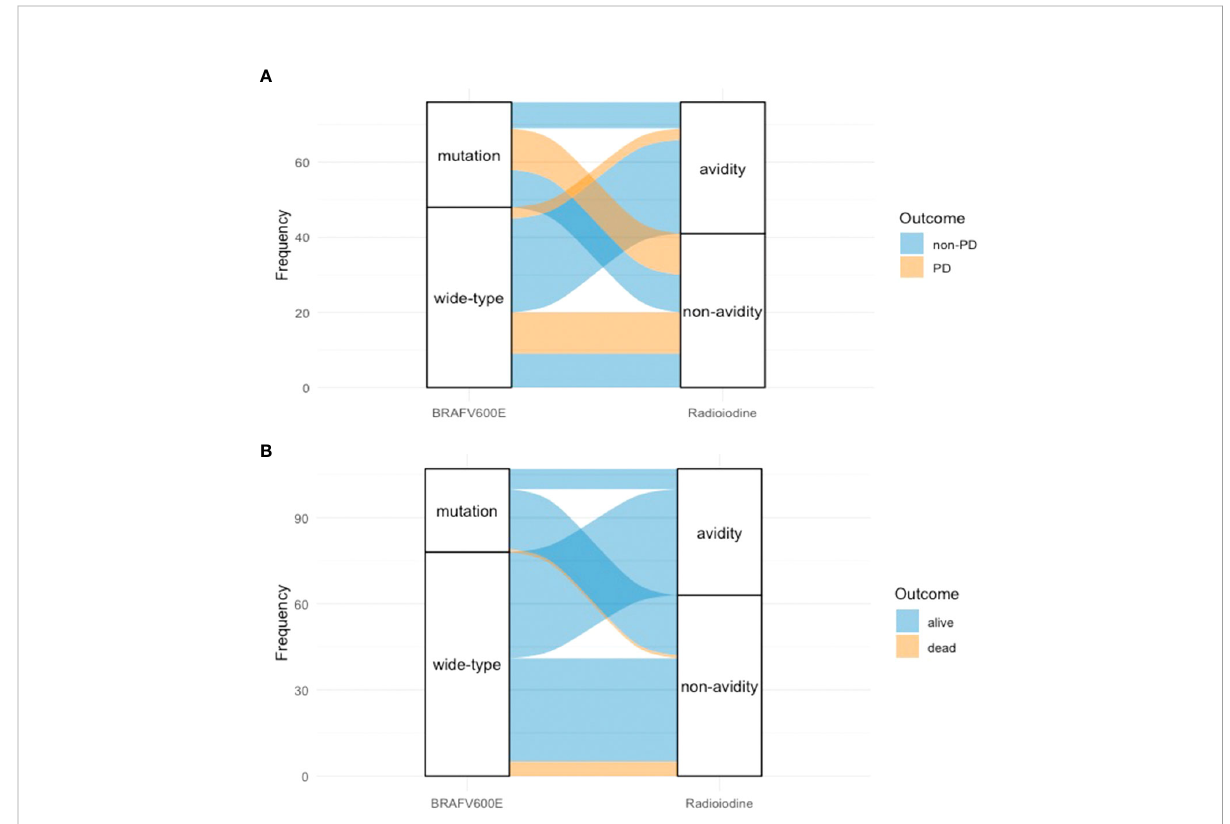
FIGURE 4 Alluvial diagram of PTC patients showed the relationship between BRAF V600E mutation status, radioiodine avidity status, and outcome. (A) BRAF V600E mutation status, radioiodine avidity status, and PD. (B) BRAF V600E mutation status, radioiodine avidity status, and mortality. PTC, papillary thyroid cancer; PD, progressive disease.